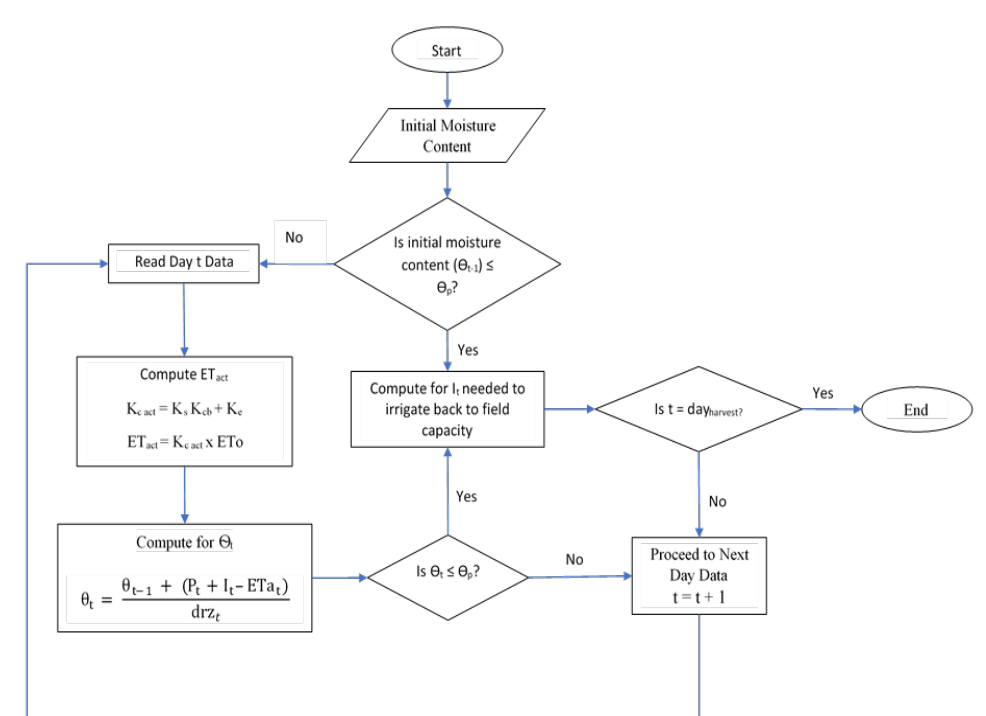
Figure 1. General workflow of the spreadsheet-based model.